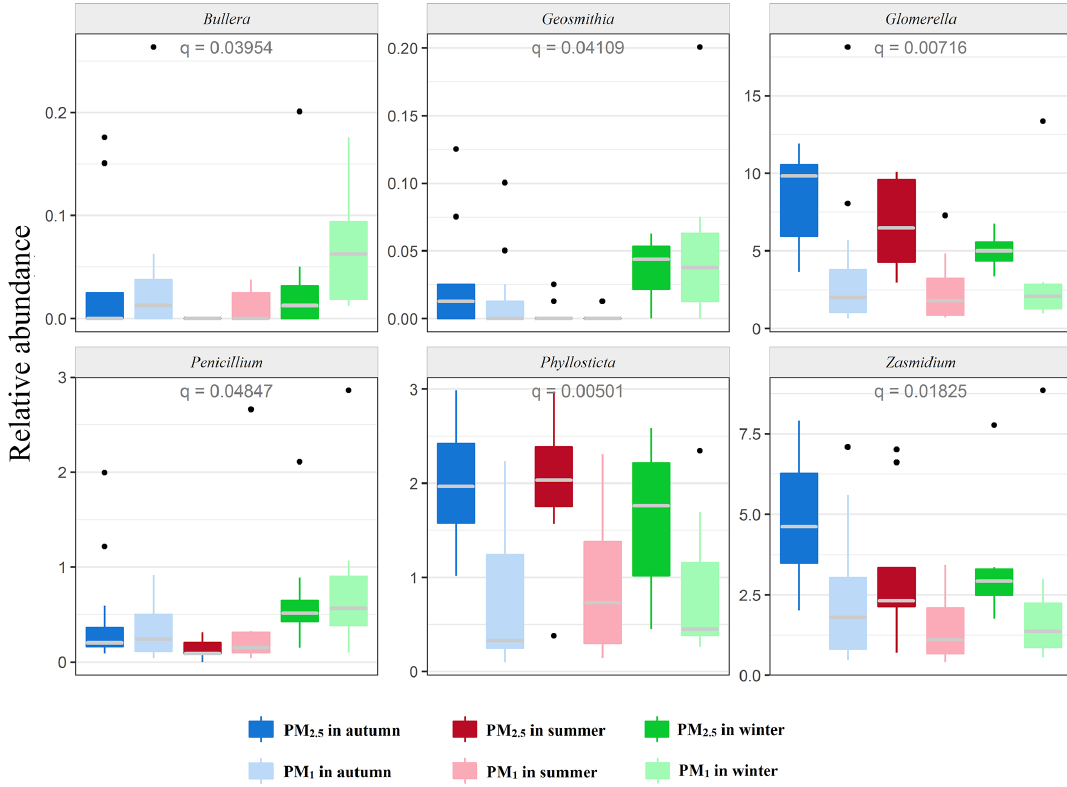
Figure 4. Variance analysis of fungal genera based on the Kruskal–Wallis rank sum test. Table 3. Metastats analysis showing the fungal genera that are significantly different among PM 2 . 5 and PM 1 . Taxa PM 1 PM 2 . 5 SE